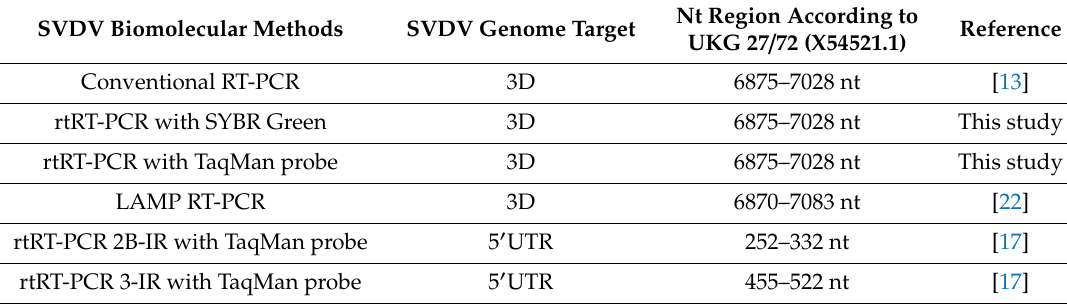
Table 1. Molecular assays evaluated in the